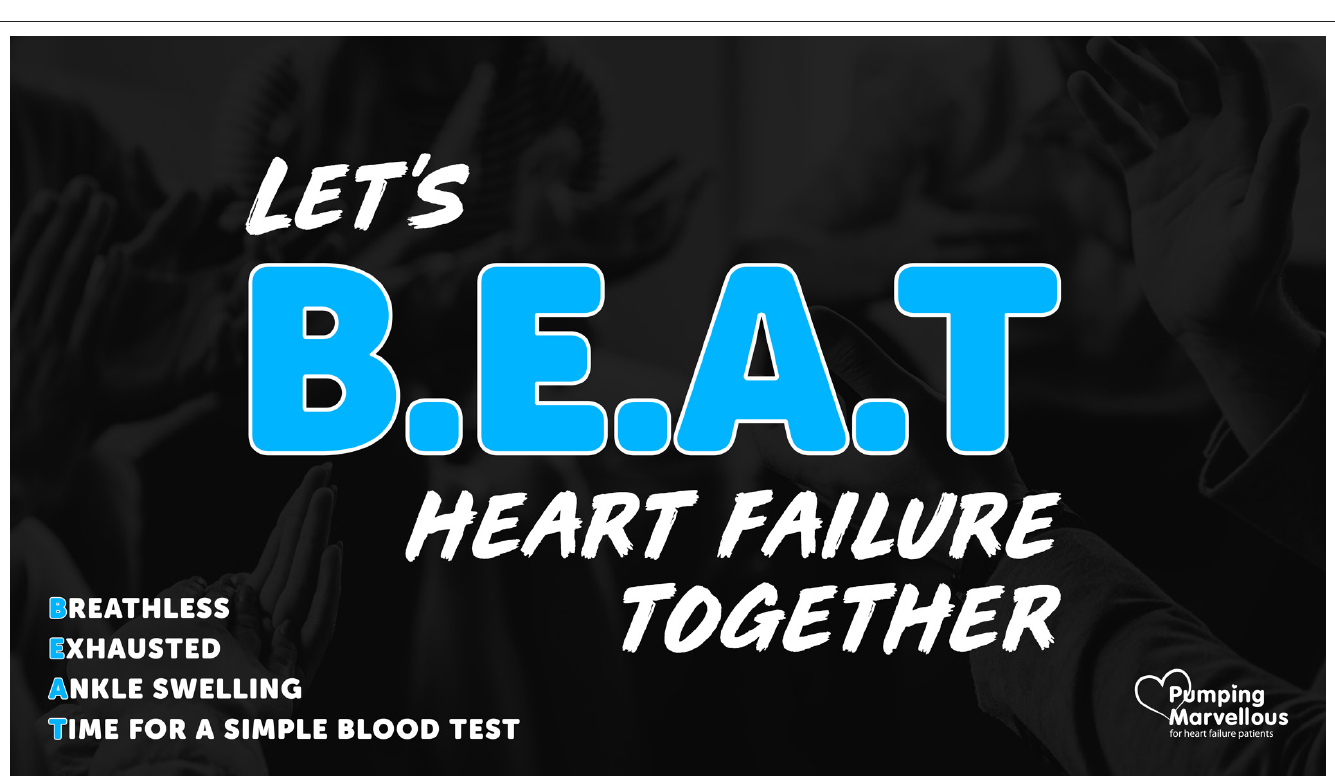
Figure 1 BEAT- HF acronym (Pumping Marvellous Foundation social media